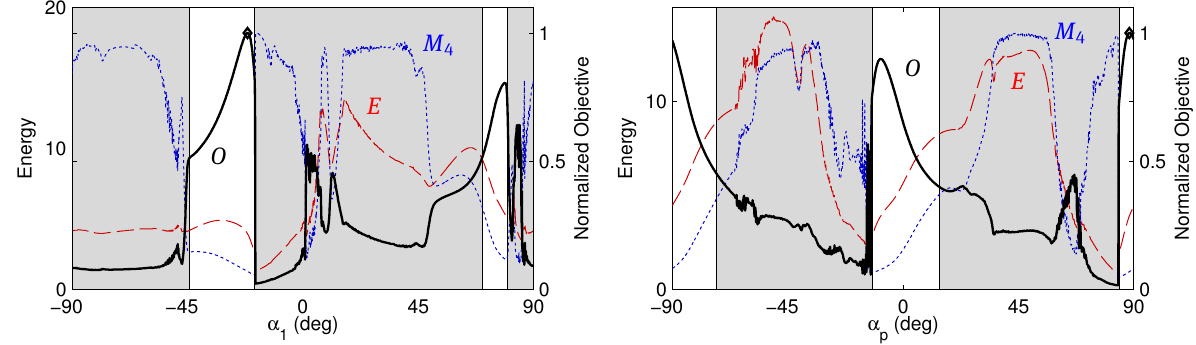
Figure 2: Objective function E / M 4 (solid black), energy E (dashed red) and fourth-moment of the spectrum M 4 (blue dots) for varying wave- plate and polarizer rotation angles α 1 and α p . Single-pulse mode-locking occurs in the white regions, i.e. the shaded gray regions are pa- rameter regimes where the cavity energy is not mode-locked. As each angle is varied, all other angles are held fixed at locally maximizing values, indicated by black